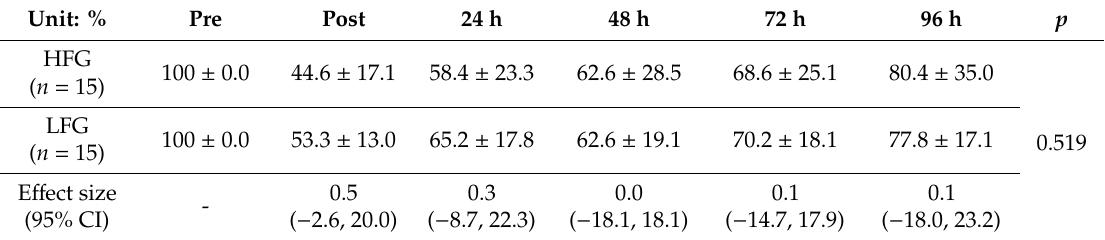
Table 2. Maximal isometric strength following eccentric exercise according to %fat.